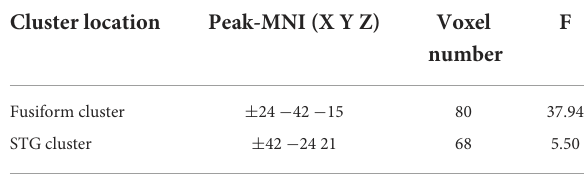
TABLE 2 One-way ANOVA comparison on VMHC among three